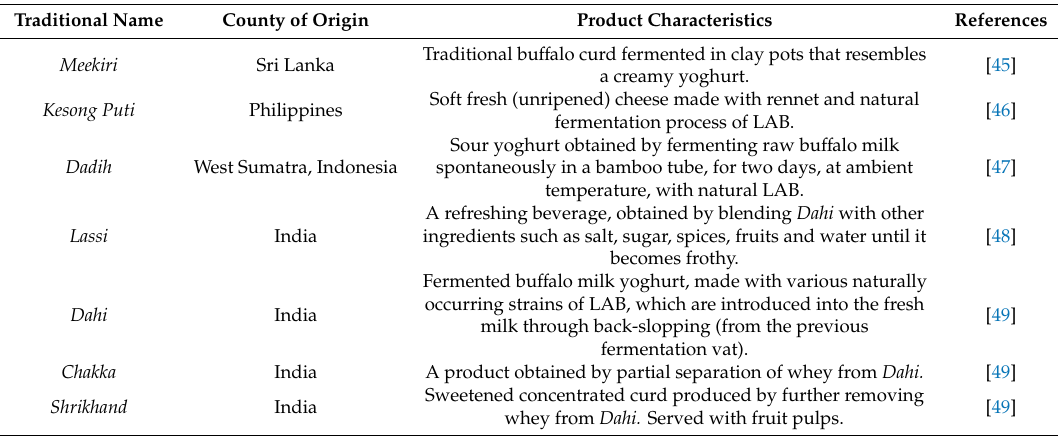
Figure 1. An extensive buffalo dairy farm in Sri Lanka ( A ), and various fermented buffalo milk products in the word, i.e., Sri Lanka— Meekiri ( B ), Philippines— Kesong Puti ( C ), West Sumatra, Indonesia— Dadih ( D ) and India— Dahi , where whey removal of Dahi occurs by hanging the fermented coagulum ( E.1 ) to produce Chakka ( E.2 ), and then it can further be processed into Shrikhand ( E.3 ), by adding optional fruit pulps (e.g., mango). Dahi can be prepared in drinkable format, by mixing with water, Lassi ( F ). Table 3. Various fermented buffalo milk products available in the world.